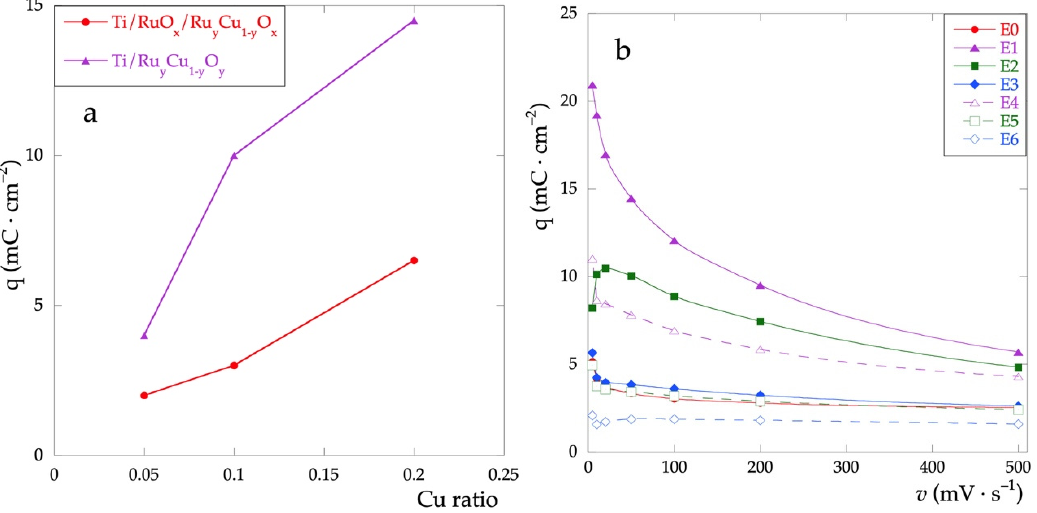
Figure 5. ( a ) Voltammetric charge calculated in the potential range between 0 and 0.9 V; ( b ) voltam- metric charge as a function of scan rates in the range 5–500 mV·s − 1 .